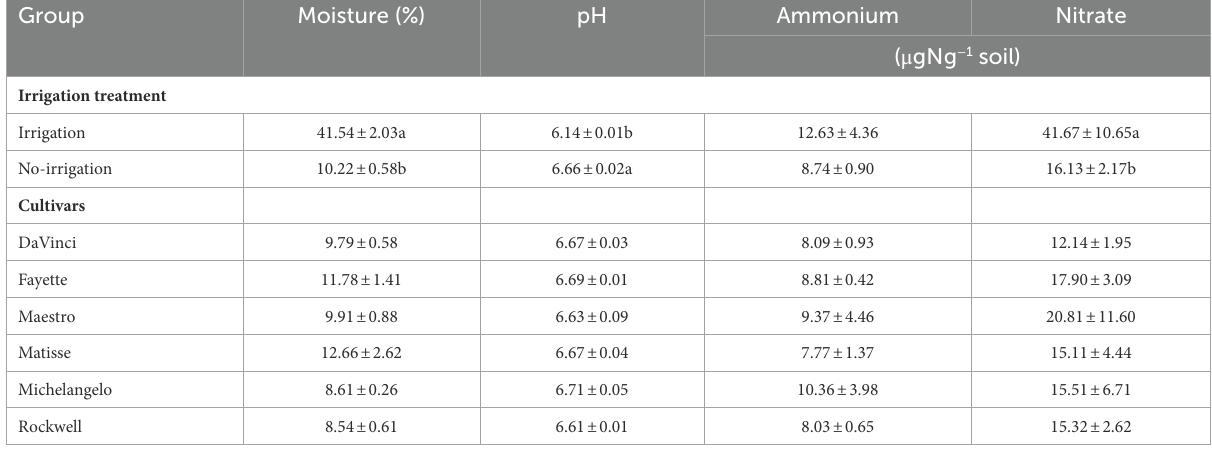
TABLE 1 Soil properties as affected by irrigation treatments and tall fescue cultivars under no irrigation.